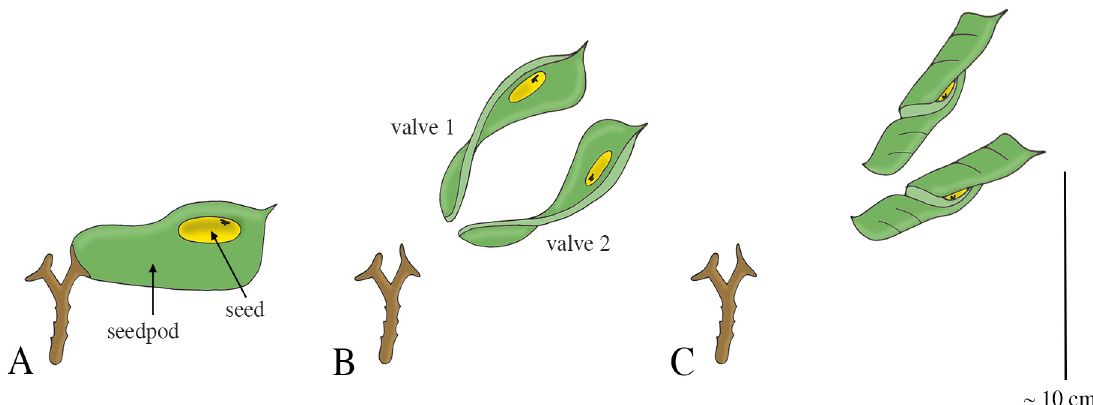
Fig 15. Drying coiling catapult mechanism in Tetraberlinia moreliana . (A) A fruiting pedicel with one mature seedpod, consisting of two valves (right) and one exploded seedpod (left). Drying of the valves causes tension in the connection between the valves and stalk of the fruiting pedicel, as the preferred dry shape of the valves is helical. (B) Dehiscence of the valves discharges the seeds. (C) Fully dried valve with seed. Drawings based on schematic drawings in [78]. Scale bar 10